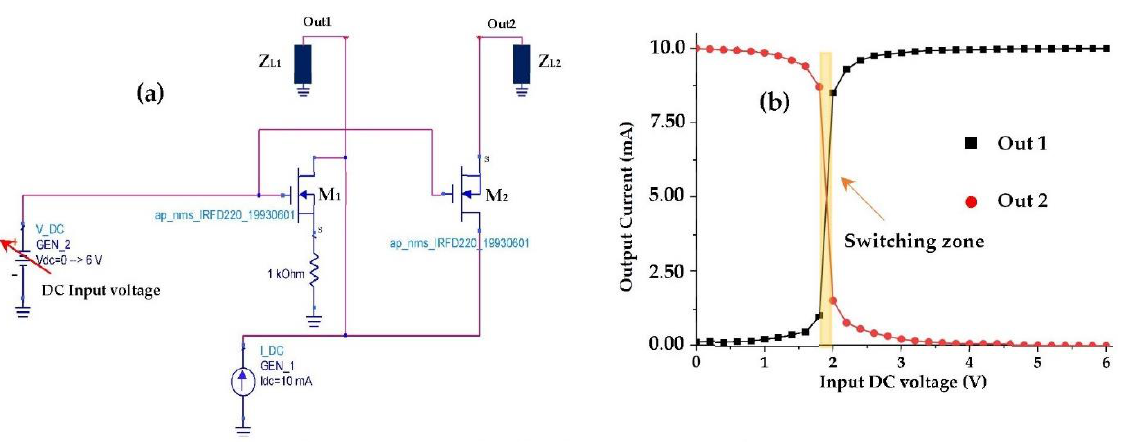
Figure 21 . ( a ) Realized RF-EH 2 , ( b ) Prototype of measurement at 22 m from relay antenna .